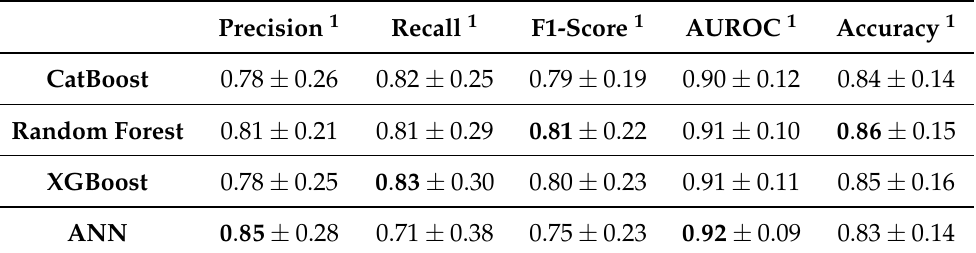
Table 4. Comparison between the different models results of a stratified 10-fold cross validation test, on training data.